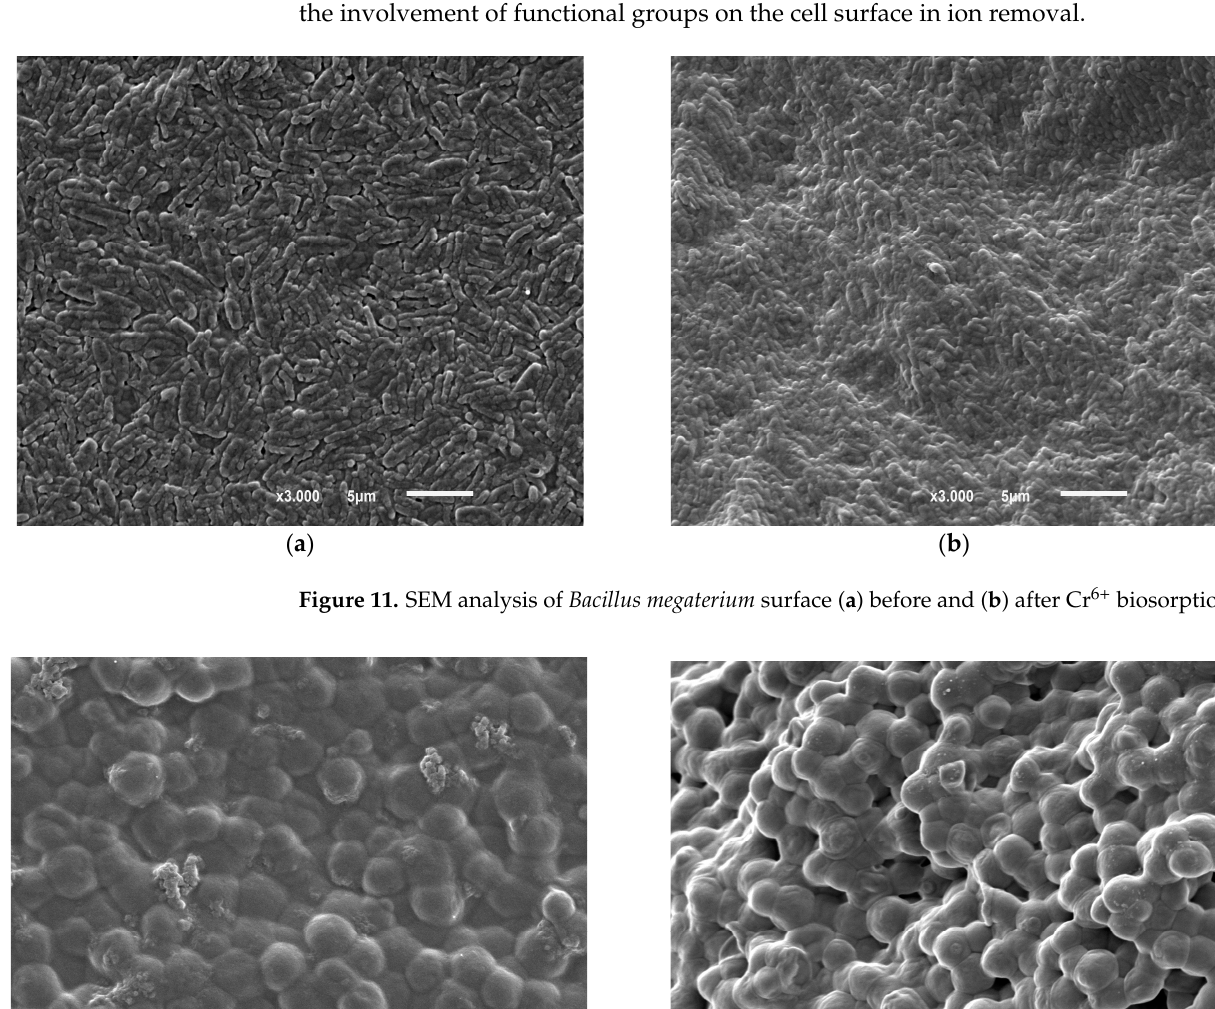
Figure 13. Elemental composition of biosorbents: ( a ) Bacillus megaterium and ( b ) Rhodotorula sp. after Cr 6+ ions